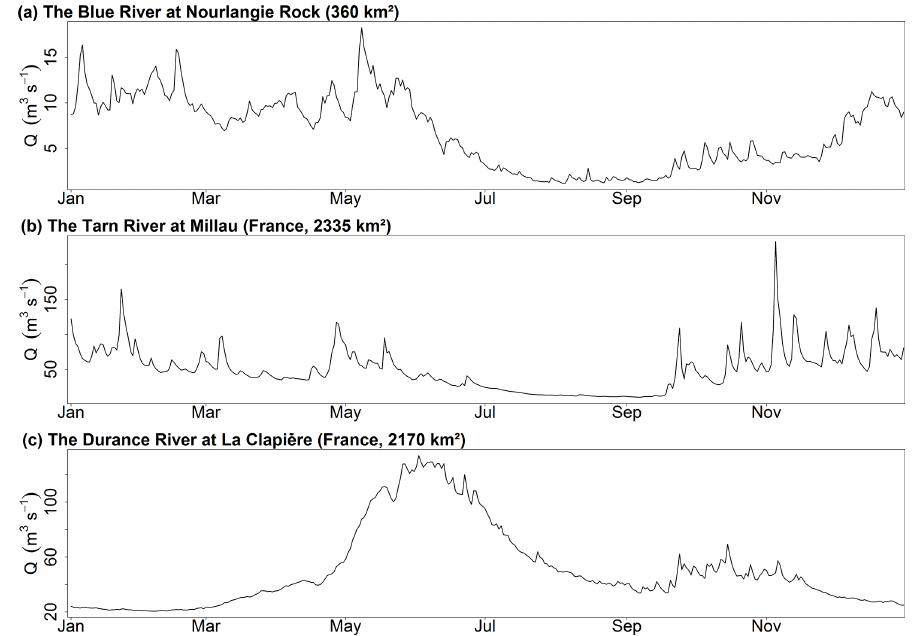
Figure 5. Daily discharge regimes at the three catchments studied.